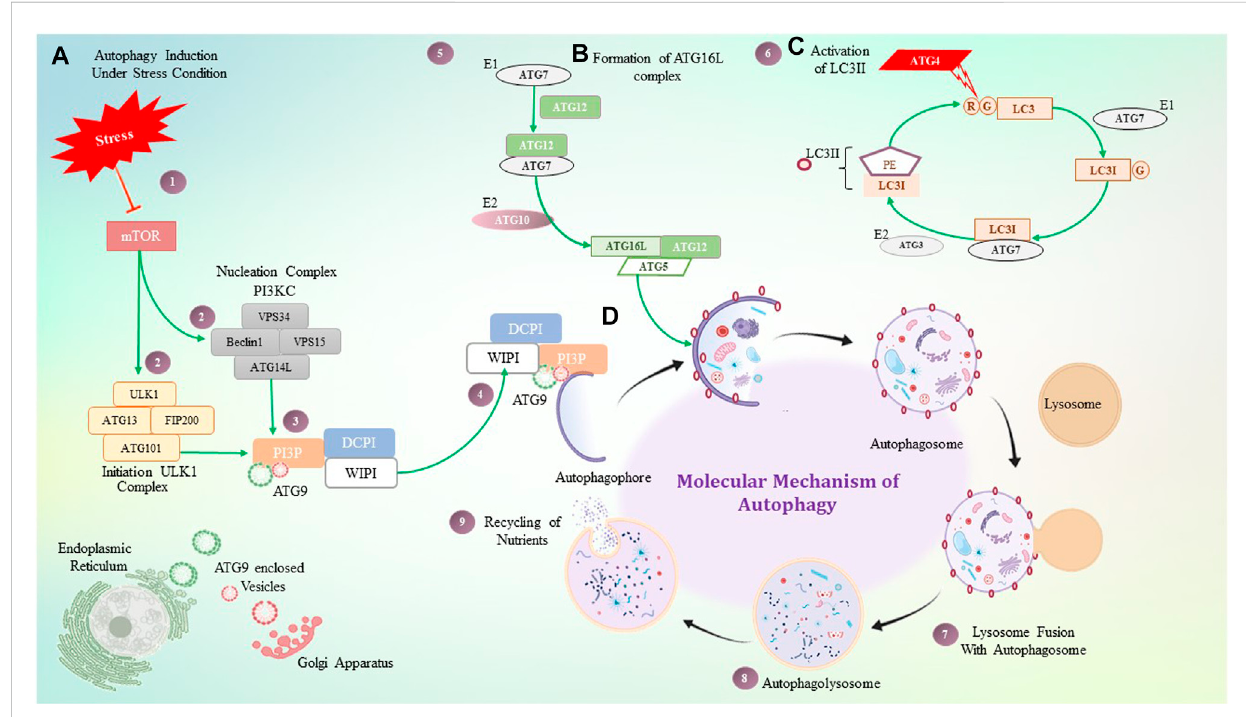
FIGURE 3 Molecular mechanism of autophagy. (A) Under stressful conditions, mTOR induces autophagy by activating the ULK1 and PI3KC3 complex, which then activates PI3P. PI3P is interacting with ATG9, DCPI, and WIPI proteins, which help with autophagosome elongation. (B) ATG16 forms a complex non-covalently with the ATG12 and ATG5 conjugate, where ATG7 plays a role as an E1-like enzyme. (C) ATG4 is a cysteine protease that cleaves LC3 protein at the glycine residue, and with the help of ATG7- and ATG3-like enzymes, it binds to PE which is termed LC3II. LC3II gets stabilized on the autophagosome with the help of the ATG16L1 complex. (D) Step-by-step diagrammatic description of autophagy shows the initial formation of the autophagosome membrane, followed by engulfment of damaged cellular components, their fusion with the lysosome, and the formation of the